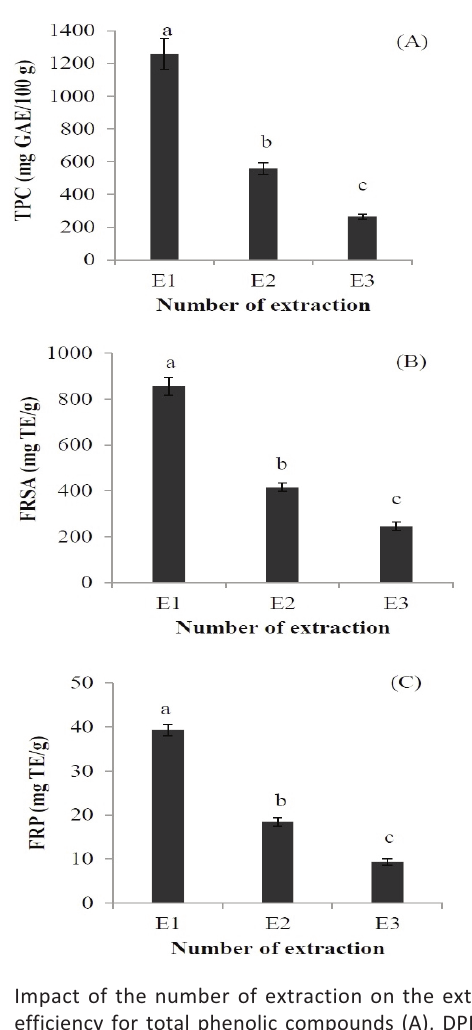
Fig. 4 ­ Impact of the number of extraction on the extraction efficiency for total phenolic compounds (A), DPPH free radical scanenging activity (B) and ferric reducing power (C) of eggplant (n= 2). Values with different letters are significantly different